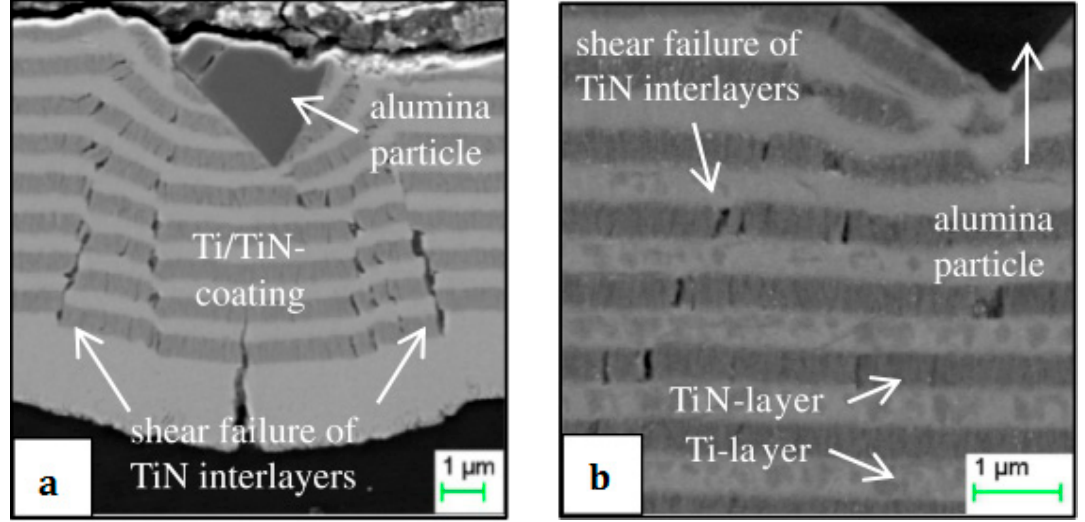
Figure 10. Shear fracture in TiN / Ti coatings with a thickness of ( a ) 10 µ m and ( b ) 30 µ m deposited on polymer matrix composite by means of a magnetron spattering method, reprinted from Wear , Reference [118], with permission from Elsevier.